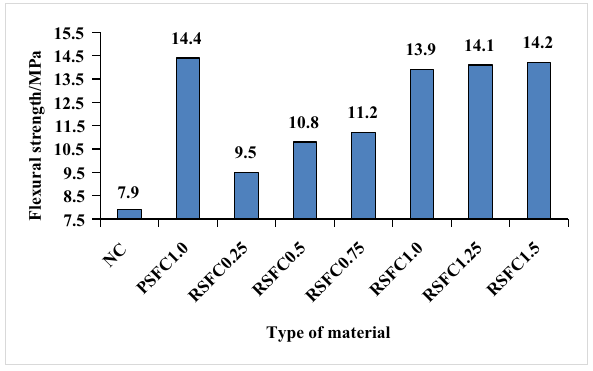
Figure 14: Flexural strength of